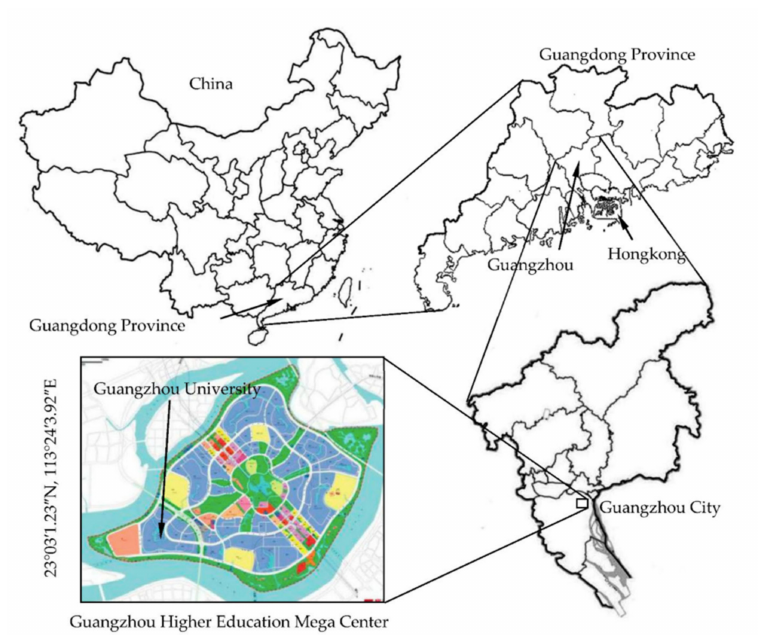
Figure 16. Location of sprinkler irrigation experiments at Guangzhou University.